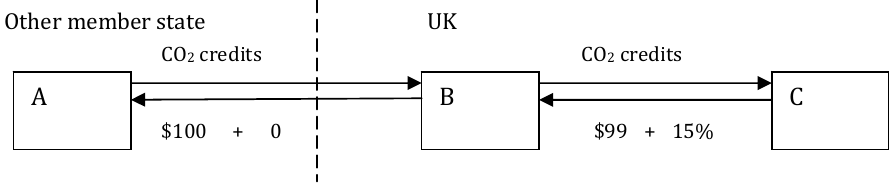
Figure 1: Simplified representation of the Missing Trader